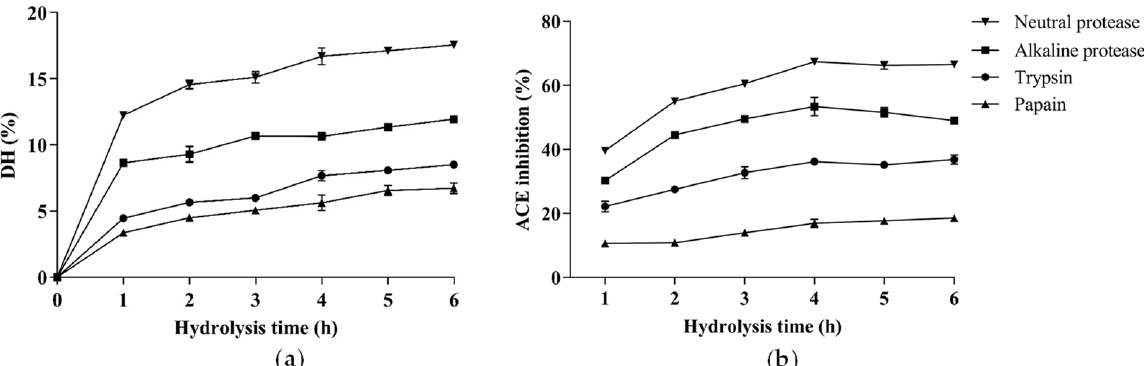
Figure 1. The degree of hydrolysis (a) and ACE inhibitory activity (b) of hydrolysates with alkaline protease, papain, neutral protease, and trypsin. The results are presented as the means ± SD (n = 3).